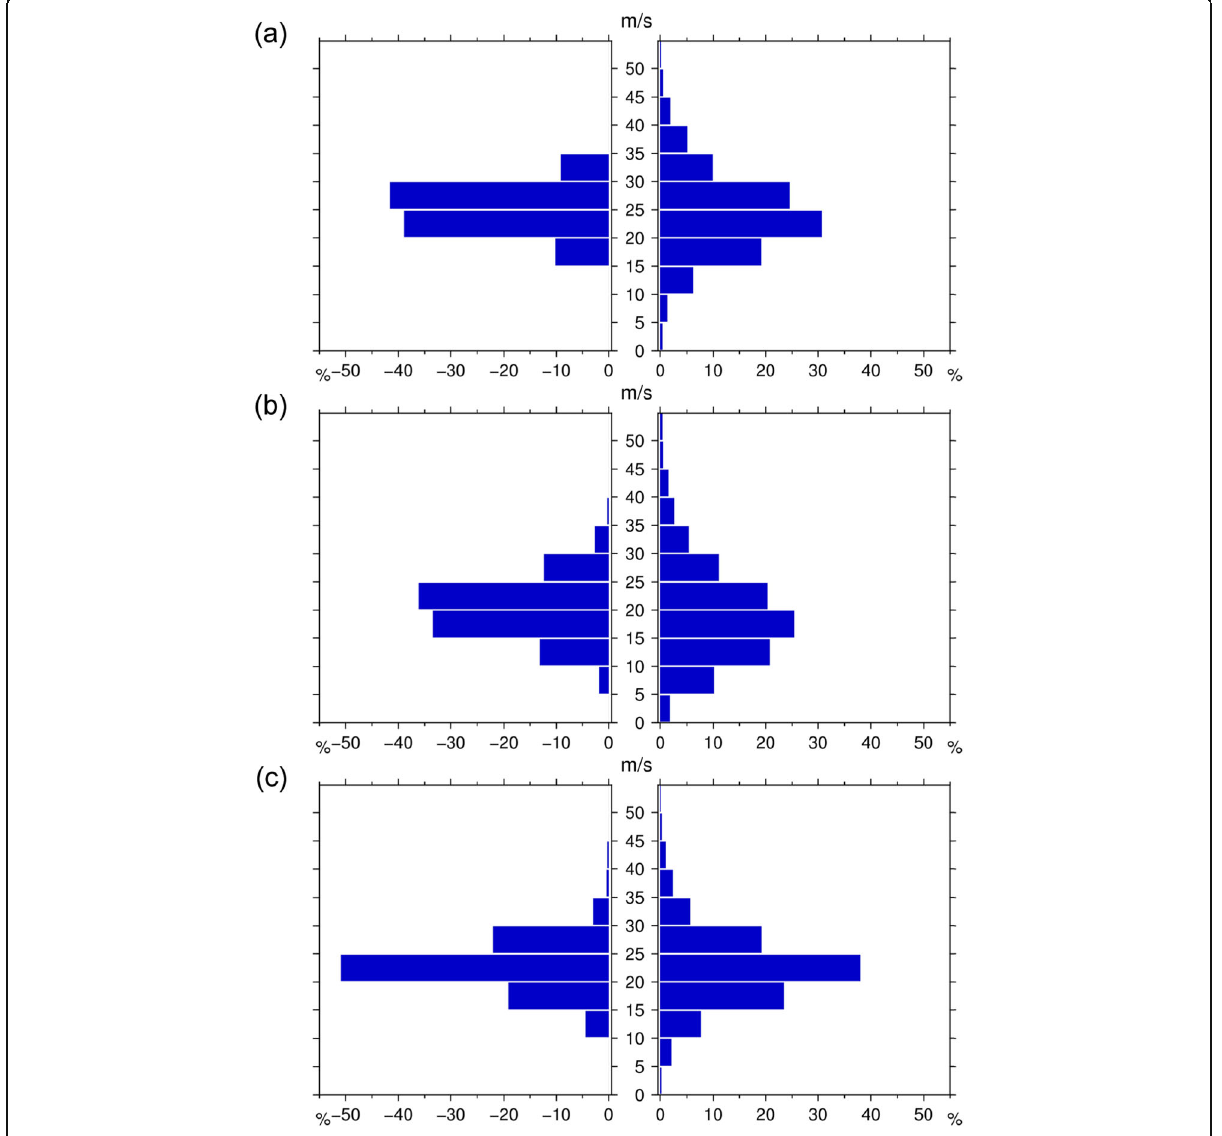
Fig. 5 The frequency distribution of the maximum surface wind speeds in the analysis areas. The relative frequency distribution (in %) of the maximum wind speeds during the simulated time period at the grid points in the area ( a ) A, ( b ) B, and ( c ) C for (left) the 1 km grid case and (right) the 200 m grid